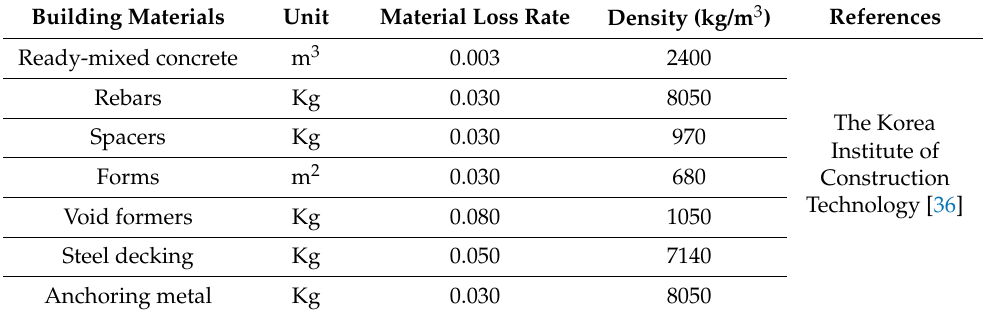
Table 1. Profile of the building